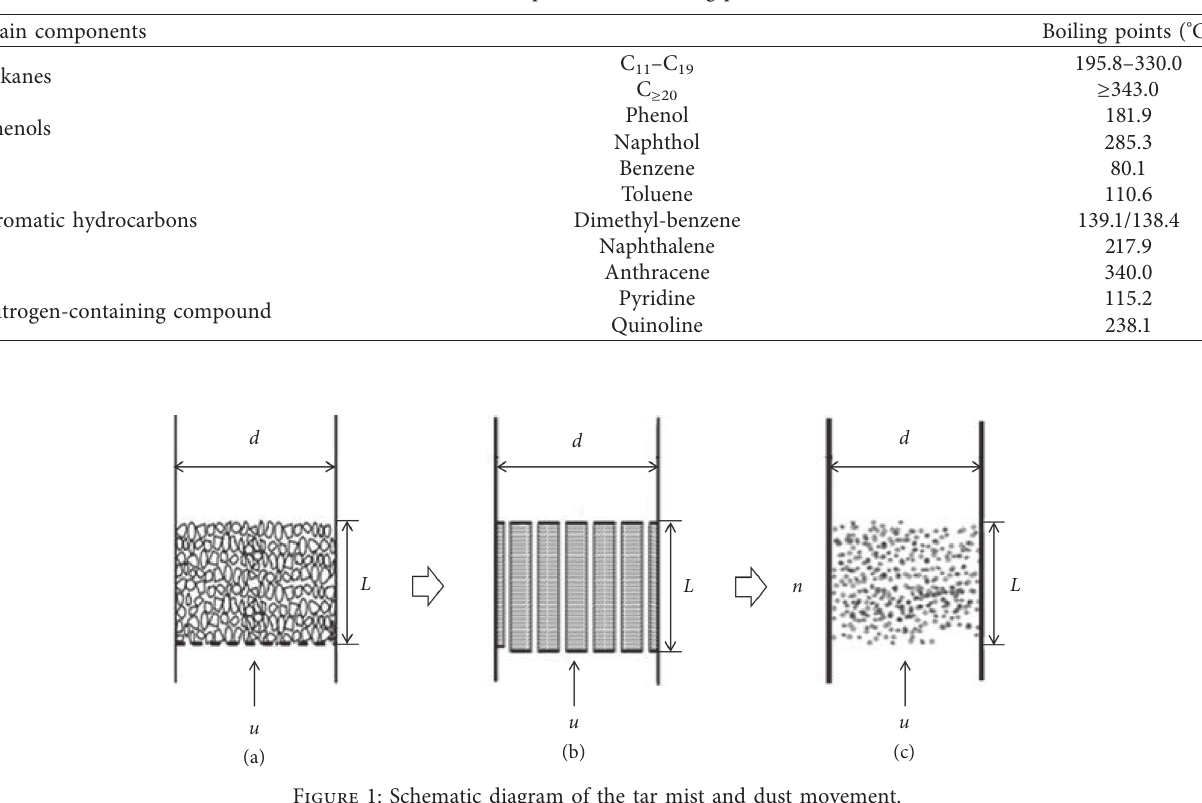
Table 1: Main components and boiling points of